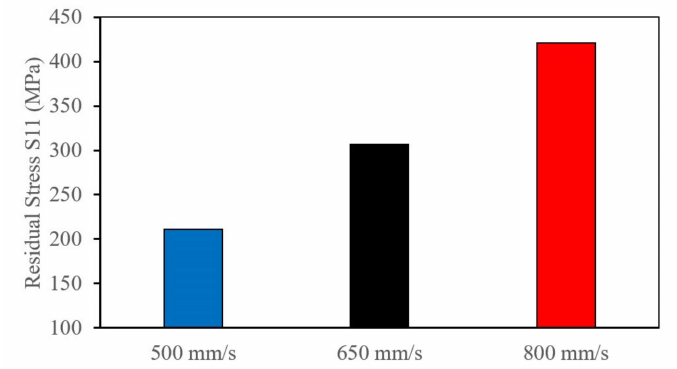
Figure 24. Effect of scan speed on the surface